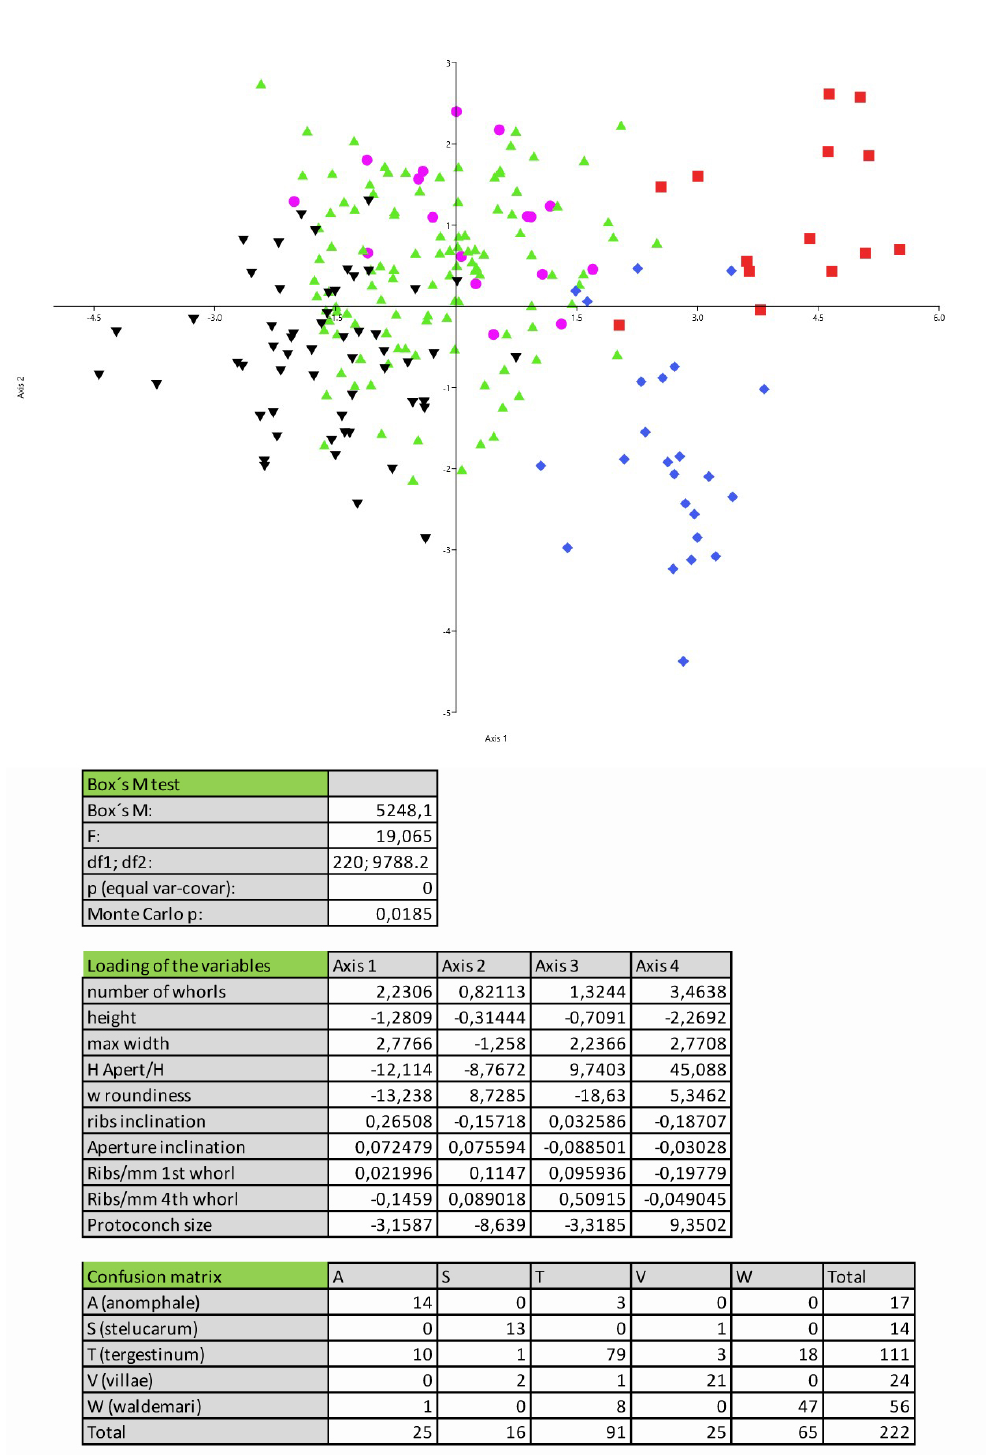
Fig. 8. Discriminant analysis based on shell features of the species in Clessiniella Zallot et al ., 2015. Violet dots = Cochlostoma ( Clessiniella ) anomphale Boeckel, 1939; red squares = Co. ( Cl. ) stelucarum sp. nov.; green triangles = Co. ( Cl. ) tergestinum (Westerlund, 1878); blue diamonds = Co. ( Cl. ) villae (Strobel, 1851); black triangles = Co. ( Cl. ) waldemari (A.J. Wagner, 1897). Analysis performed with the software ‛Past’